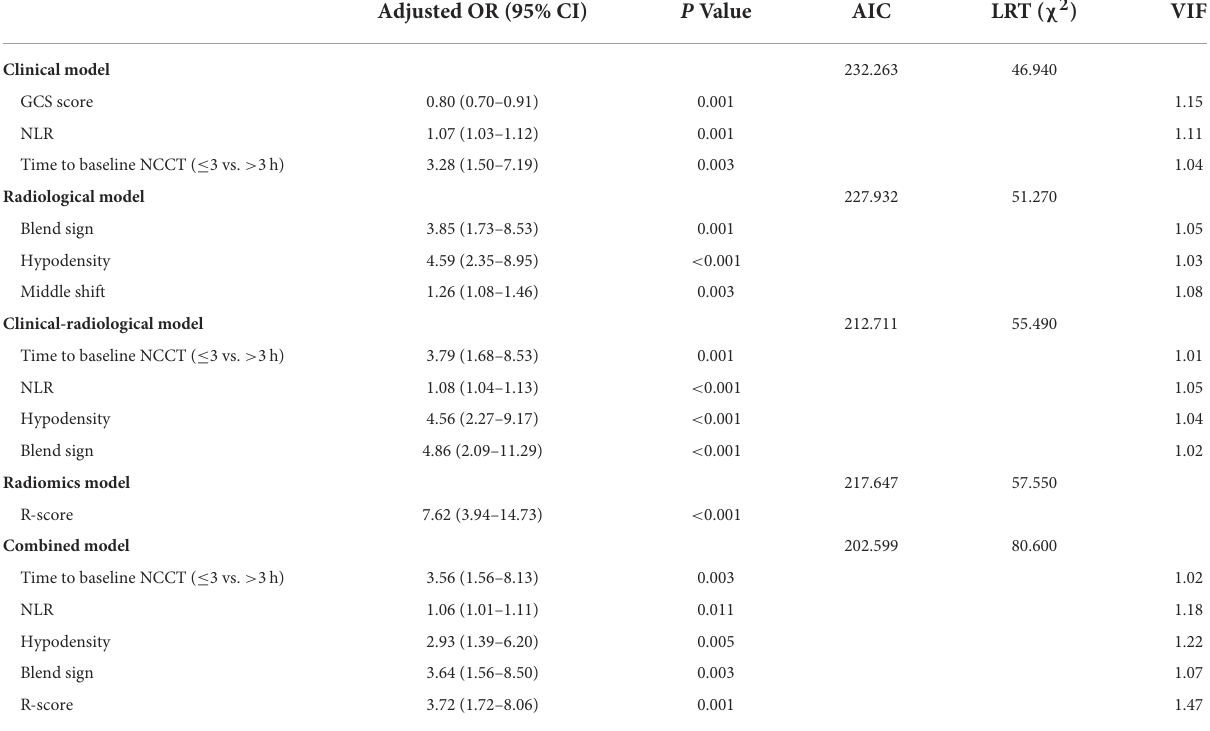
TABLE 4 Construction and comparison of five HE prediction models in the training